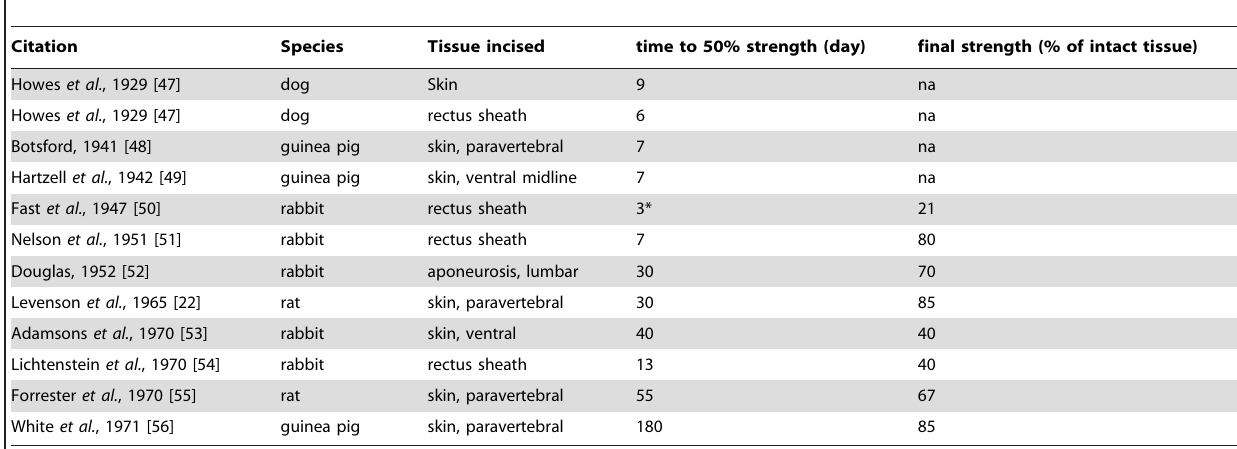
Table 2. Gain of tensile strength after incision and suture of various tissue (previous literature).